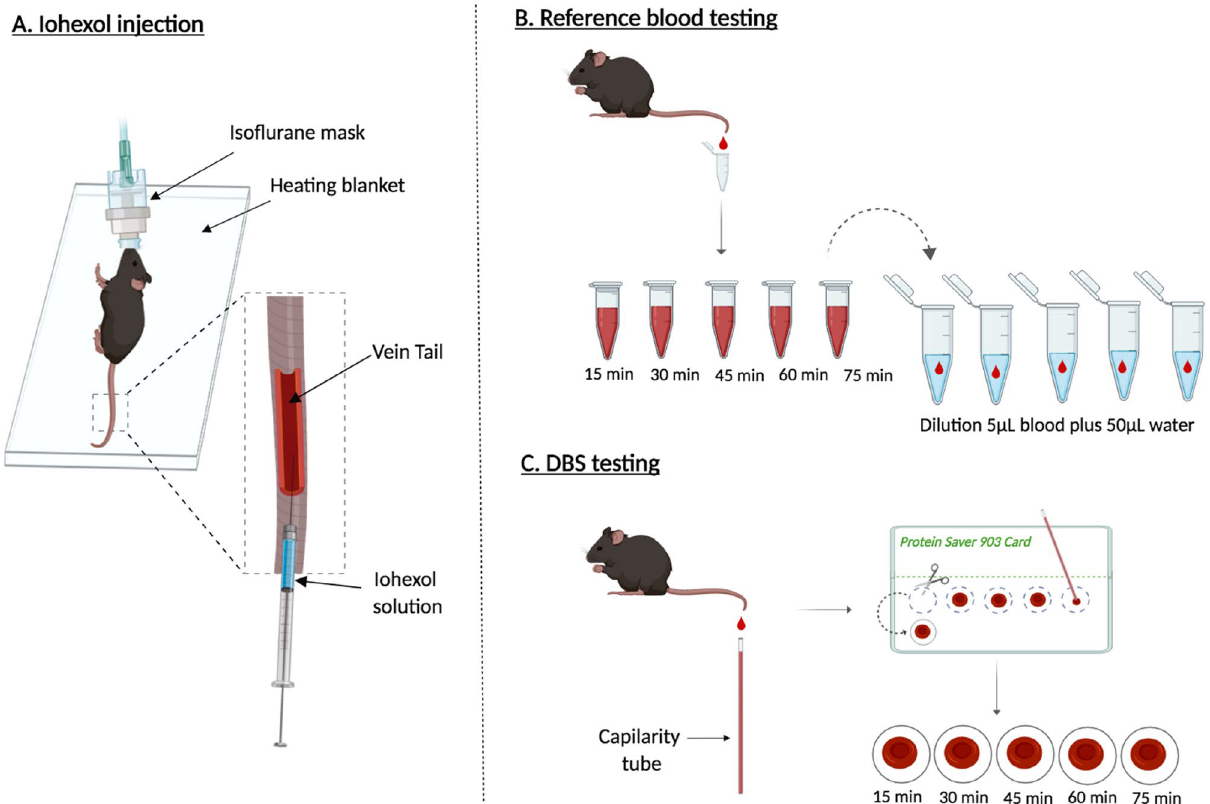
Figure 2. Experimental design. Male and female mice were used. ( A ) Iohexol injection : after slight sedation with isoflurane, 100 µL of iohexol solution mice were injected intravenously into the tail vein. ( B ) Reference blood testing: 15, 30,45, 60 and 75 min after injection a drop of blood (~ 10 µL) were collected from the tip of the tail and deposited in a tube. Then. 5 µL are taken from the tube and diluted in 50 µL of water. ( C ) DBS testing : at the same times , exactly 5 µL of blood were taken using heparinized capillary tubes and deposited in filter paper. Then, after 24 h drying, samples are cut-off for analysis. Figure designed and made by Dr. Ana Elena Rodriguez- Rodriguez using the Biorender application in its free version ( https ://app.biore nder.com